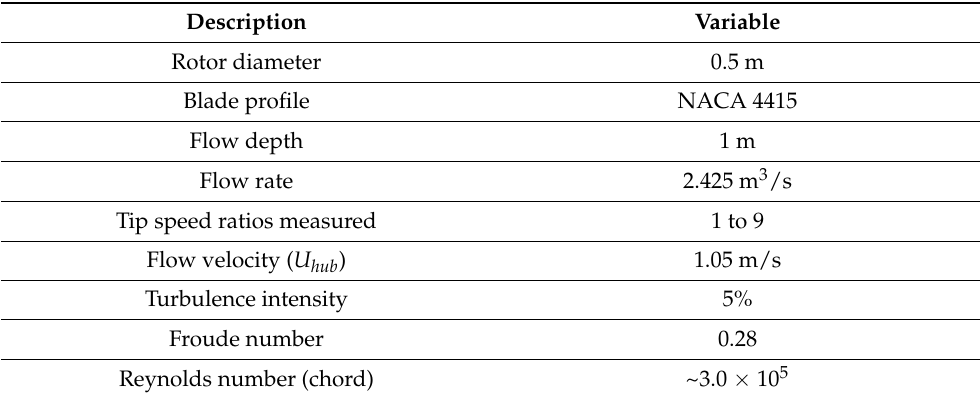
Table 3. RM1 laboratory setup details